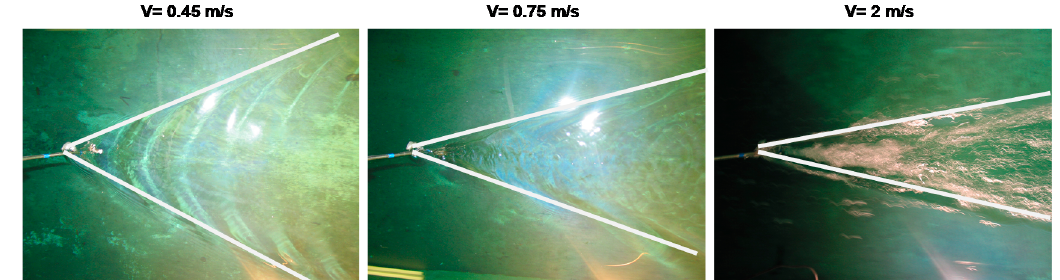
Figure 2. Towing tank experiments for testing the hypothesis.